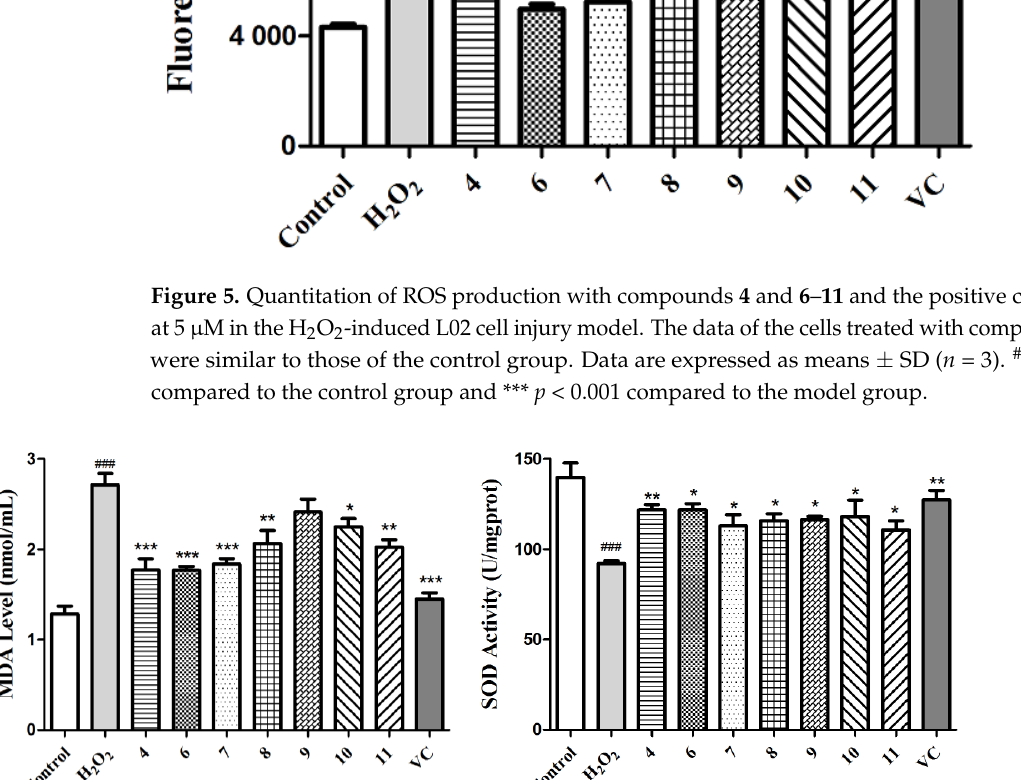
Figure 6. Determination of the MDA levels and SOD activities for compounds 4 and 6 – 11 and the positive control (VC) at 5 µM using the H 2 O 2 -induced L02 cell injury model. The data of the cells treated with compounds only were similar to those of the control group. Data are expressed as means ± SD ( n = 3). ### p < 0.001 compared to the control group and * p < 0.05, ** p < 0.01, and *** p < 0.001 compared to the model group.